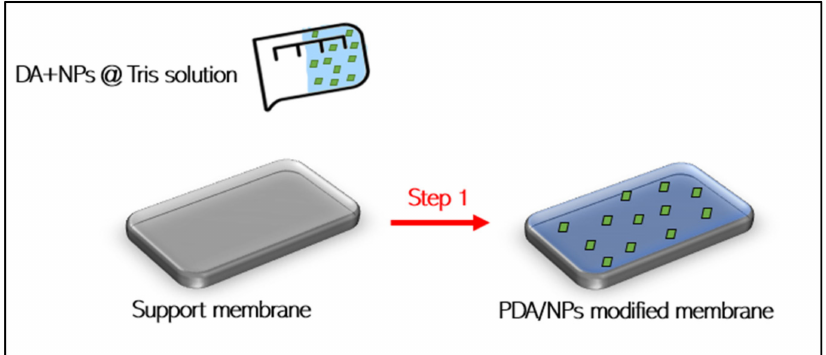
Figure 3. One-step modification